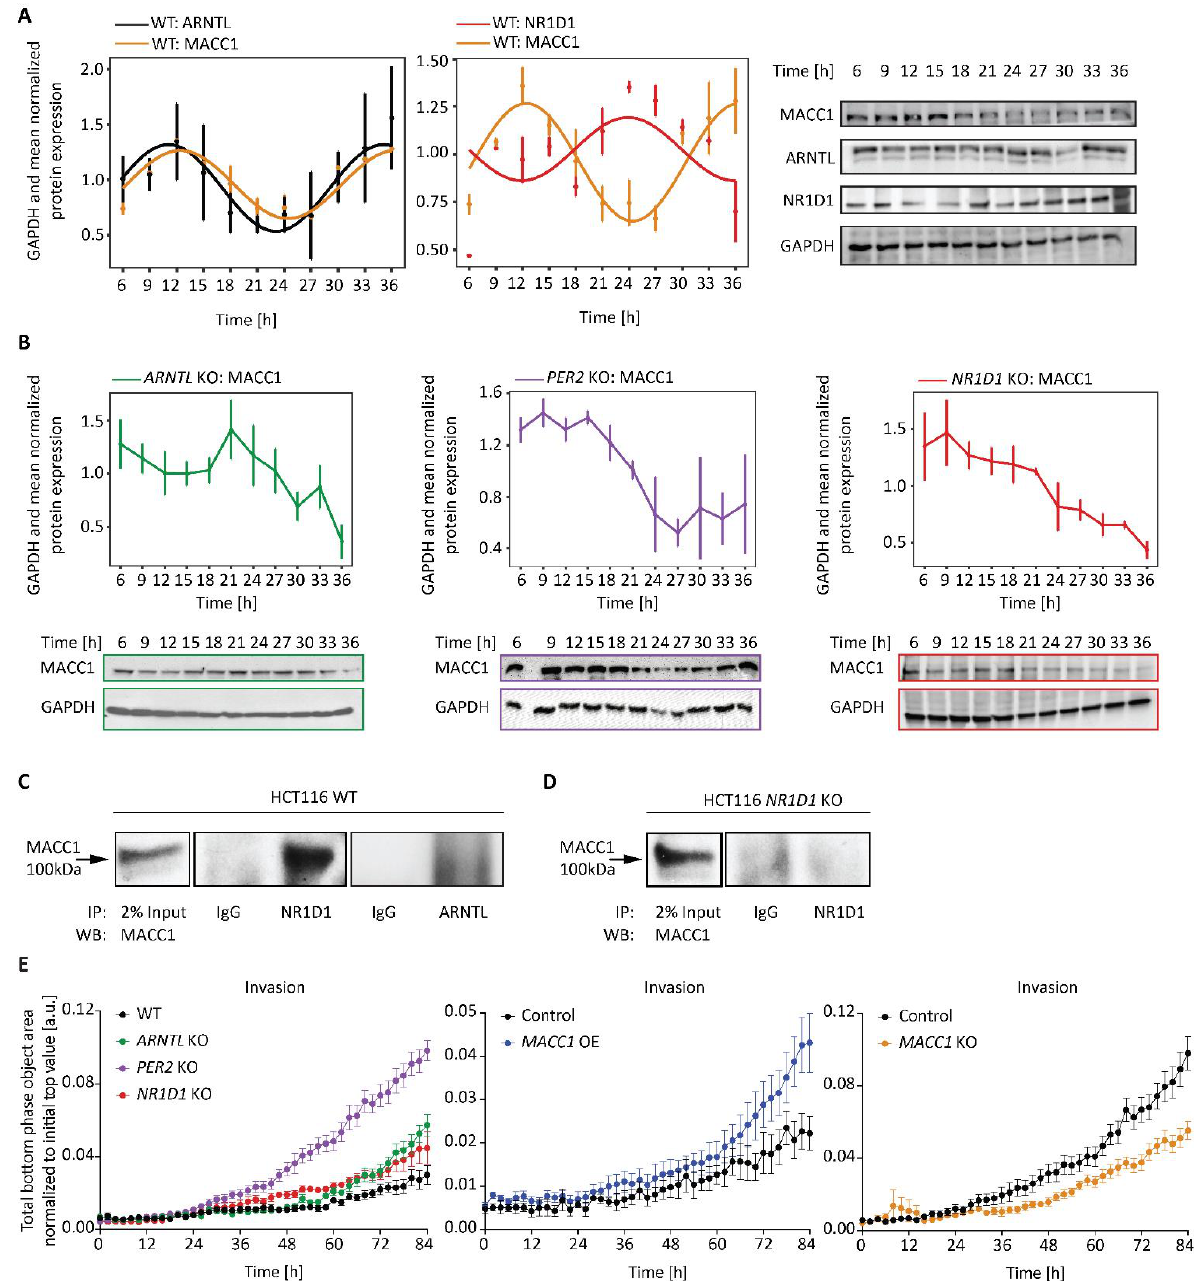
Figure 6. MACC1 protein oscillates similar to ARNTL and antiphase to NR1D1 in HCT116 cells. 30 h time-course protein expression via Western blotting in HCT116 WT ( A ) and core-clock KO cells ( B ). ( A ) ARNTL, NR1D1 and MACC1 expression in synchronized WT cells. ( B ) MACC1 expression in synchronized WT, ARNTL KO, PER2 KO and NR1D1 KO cells. GAPDH and mean normalized data is presented ( n = 3, mean ± SEM). Rhythmicity analysis was performed using Cosinor in Dis- corhythm R package for a period of 24 h. A cosine curve was fitted for rhythmic data sets ( p < 0.05),